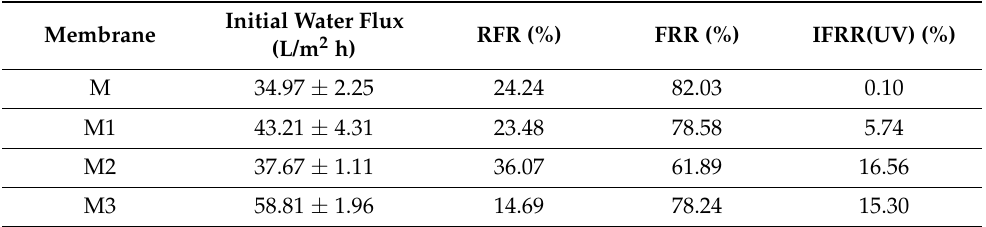
Table 6. Water flux recovery and cleaning properties of neat PVDF membrane and PVDF/TiO 2